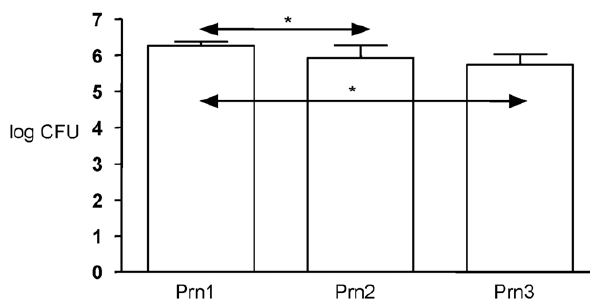
Figure 3. Effect of variation in Prn on colonization of the mouse lung. Mice were infected with clinical isolates producing Prn1 (N=15), Prn2 (N=5) or Prn3 (N=8). Three days after infection, the number of CFUs in the lung was determined. Error bars and asterisks indicate 95% confidence intervals and significant differences (P , 0.05),